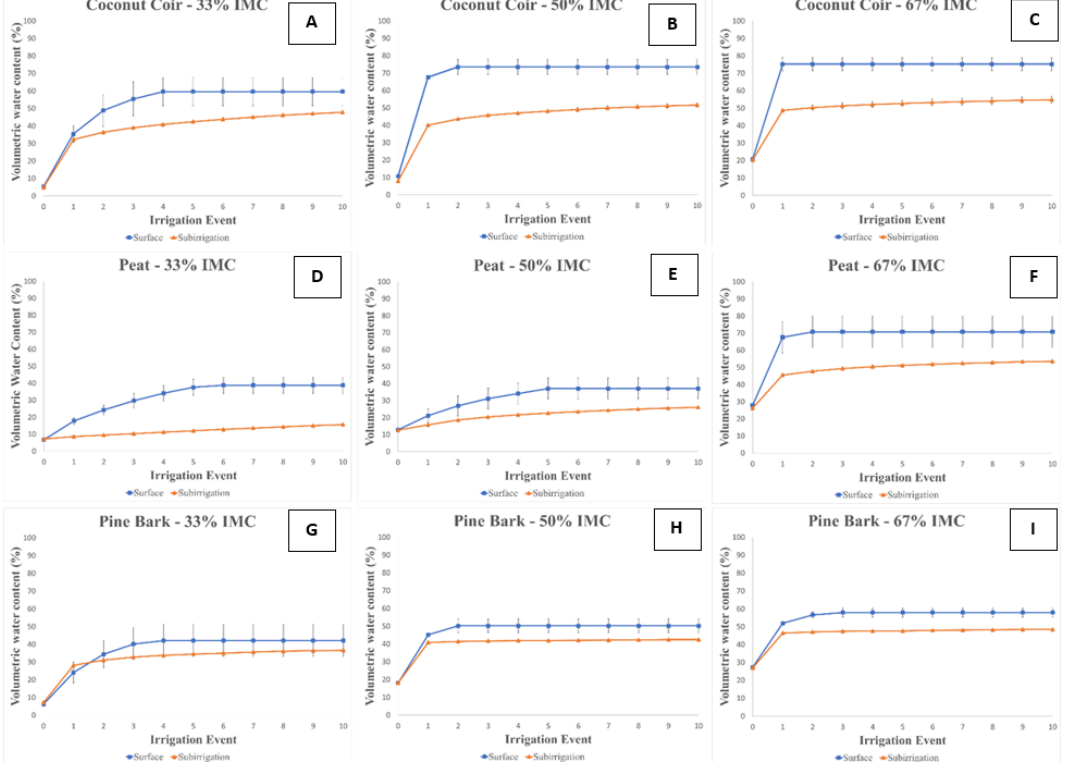
Figure 4. Substrate water capture volumetric water content curves for peat, coir, and pine bark over ten irrigation events at three moisture contents and two irrigation techniques. With ( A ) coir at 33% IMC, ( B ) coir at 50% IMC, ( C ) coir at 67% IMC, ( D ) representing peat at 33% IMC, ( E ) peat at 50% IMC, ( F ) peat at 67% IMC, ( G ) pine bark at 33% IMC, ( H ) pine bark at 50% IMC, and ( I ) pine bark at 67% IMC. The capture rate of coir was a ff ected by irrigation method. Capture rates for coir were greatest at 50% IMC (Figure 5), where 50% IMC captured ~60% VWC of water through one irrigation event whereas 67% IMC captured ~50% VWC of water in surface irrigation. However, with subirrigation the di ff erences were smaller. Initial moisture contents of 33%, 50%, and 67% were within 8% of total water captured (volumetrically) between each increase in moisture. Also, as IMC increased, the di ff erence between events one and 10 were smaller. With surface irrigation, as IMC increased, fewer events were needed to reach maximum capture. In subirrigation, the e ff ect was similar, although 33% IMC and 50% IMC showed minimal di ff erences in water